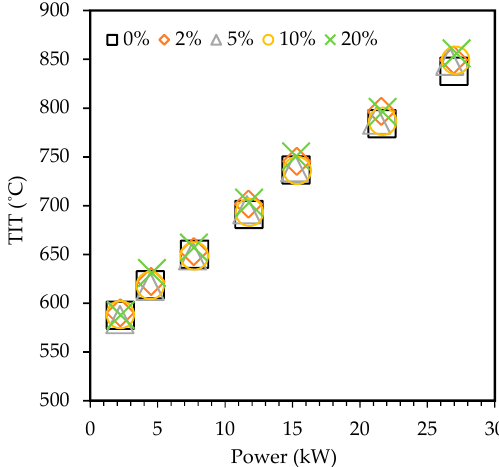
Figure 5. Variations in turbine ‐ inlet temperature (TIT) of tested fuel types. Energies 2020 , 13 , x